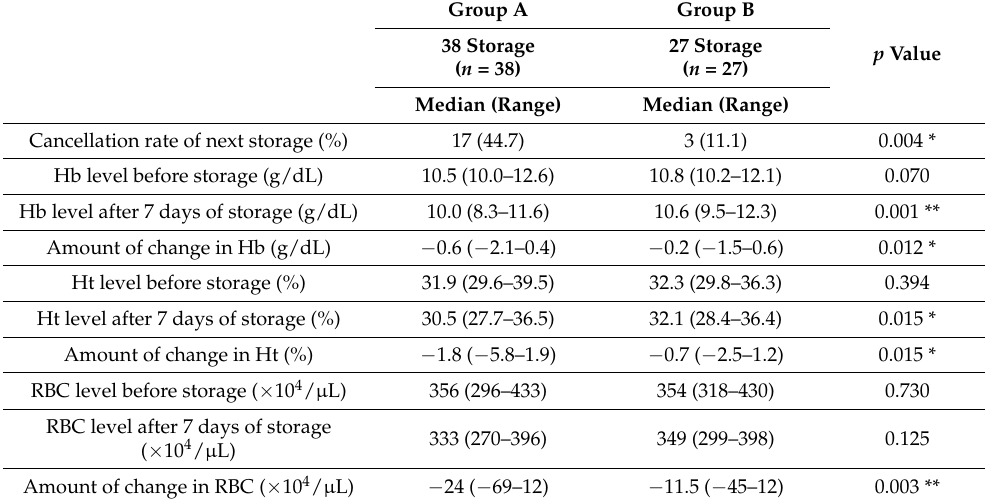
Table 3. Blood cell counts and differences in the initial autologous blood storage. Group A Group